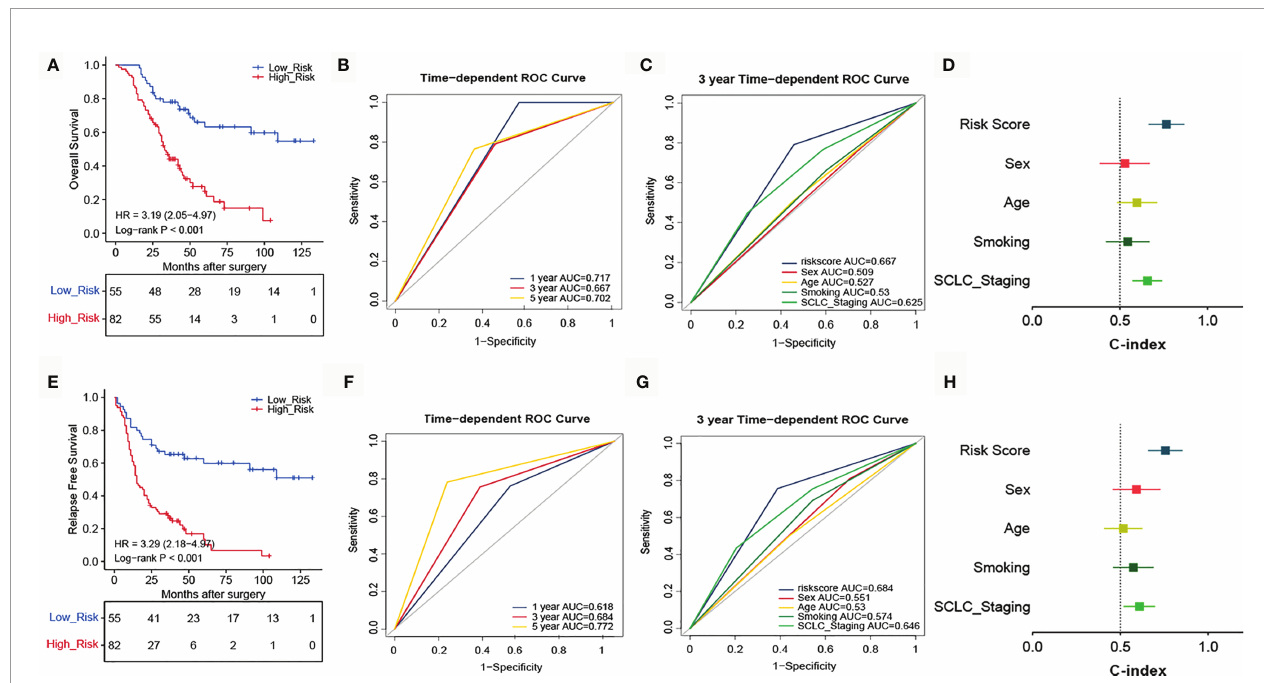
FIGURE 4 | Validation of the prognostic performance of the TNF family based-signature in the validation cohort. (A, E) Kaplan-Meier curves of OS and RFS according to risk-score groups in the validation cohort. (B, F) ROC curves of the TNF family-based signature for predicting OS and RFS after 1, 3, and 5 years. (C, G) ROC curves of the TNF family-based signature for predicting 3-year outcomes of OS and RFS. (D, H) C-index for the predictive performance of the signature for OS and